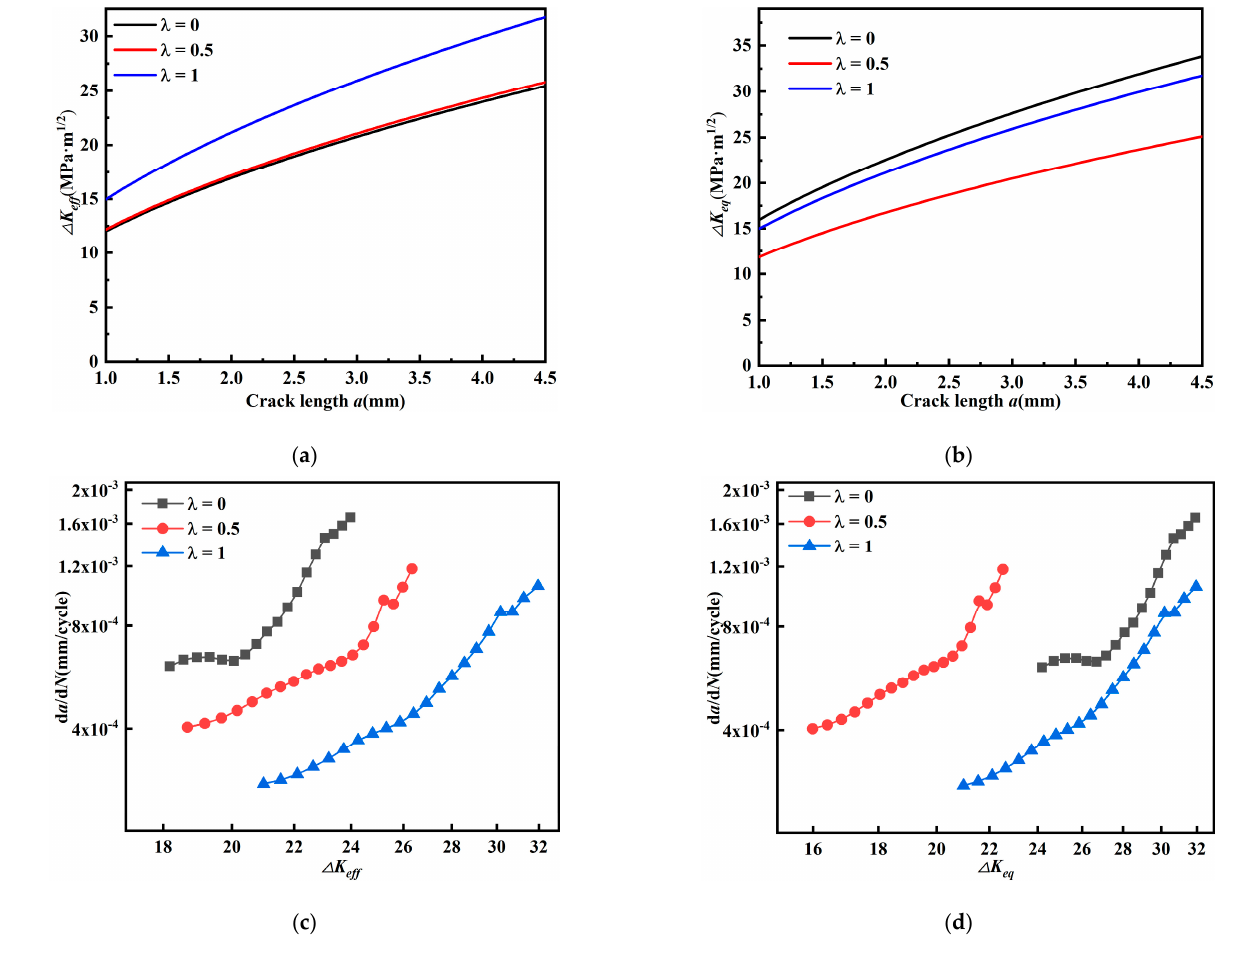
Figure 13. Relationship between crack length, equivalent and effective stress intensity factor ampli- tude, and da/dN ( β =45°). ( a ) Relationship between a and △ K eff , ( b ) relationship between a and △ K eq , ( c ) relationship between △ K eff and da/dN , and ( d ) relationship between △ K eq and da/dN .